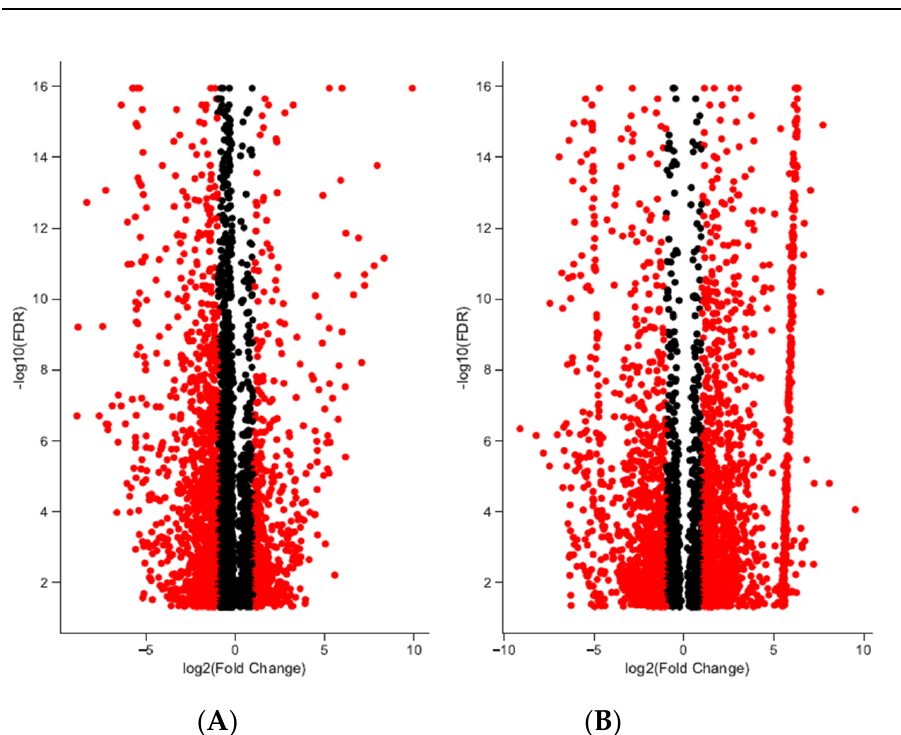
Figure 1. Differentially expressed transcripts in brain and gonadal tissue in loggerhead sea turtles reared below and above 29 °C. Significant differentiation from fold change (FC) of two is indicated in red (FDR < 0.001). In brain ( A ), 774 and 1513 transcripts are significantly up- and downregulated with fold change greater than 2; 1270 and 872 transcripts with fold change greater than 2 are significantly up- and downregulated in gonads ( B ).